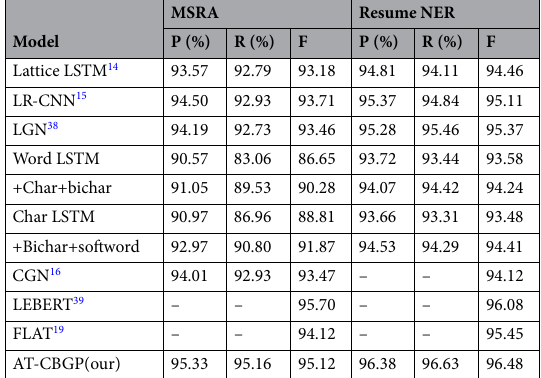
Table 3. Experiment results on MSRA & resume